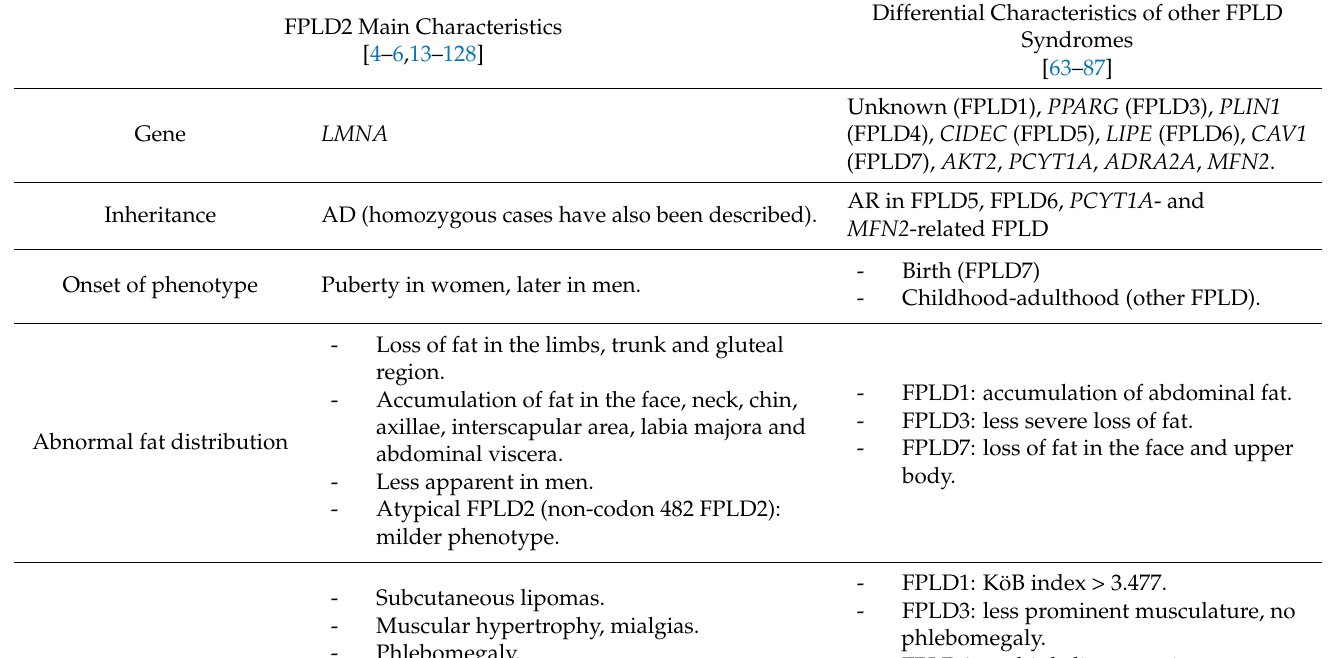
Table 1. Clinical characteristics of FPLD2 and its differential diagnosis with other familial partial lipodystrophy